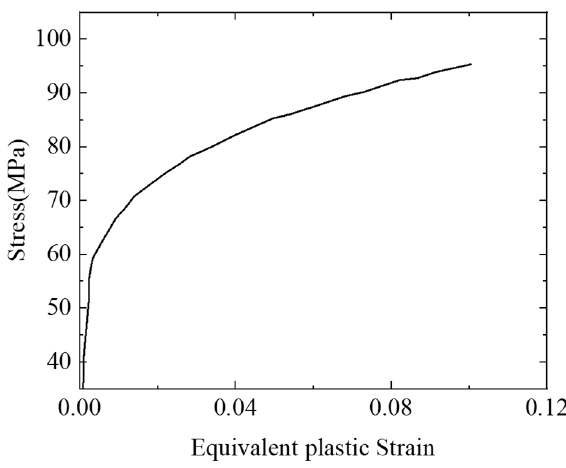
Figure 4. Stress-equivalent plastic strain curve of matrix resin